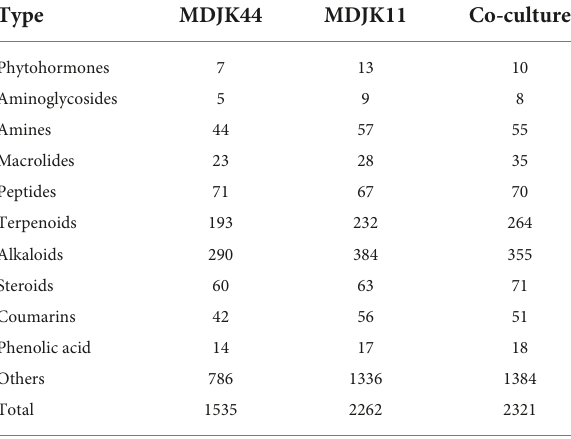
TABLE 2 Statistics and classification of the identified metabolites in Streptomyces MDJK11 and MDJK44 in monoculture and